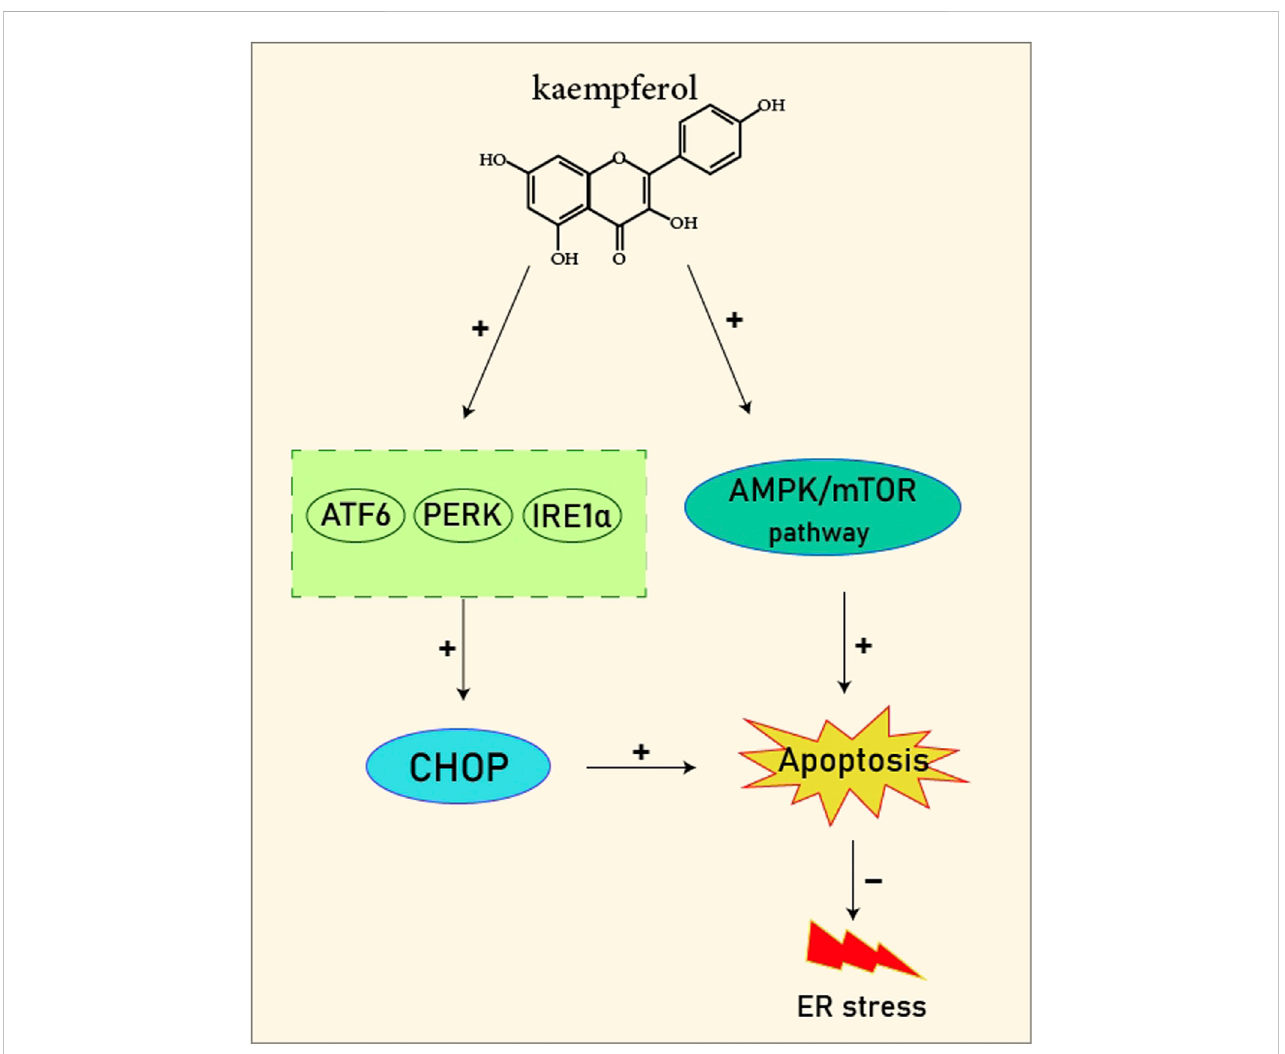
Kaempferol induces CHOP through IRE1a, PERK, ATF6 and also induces AMPK/mTOR, which induce apoptosis and as result reduce ER